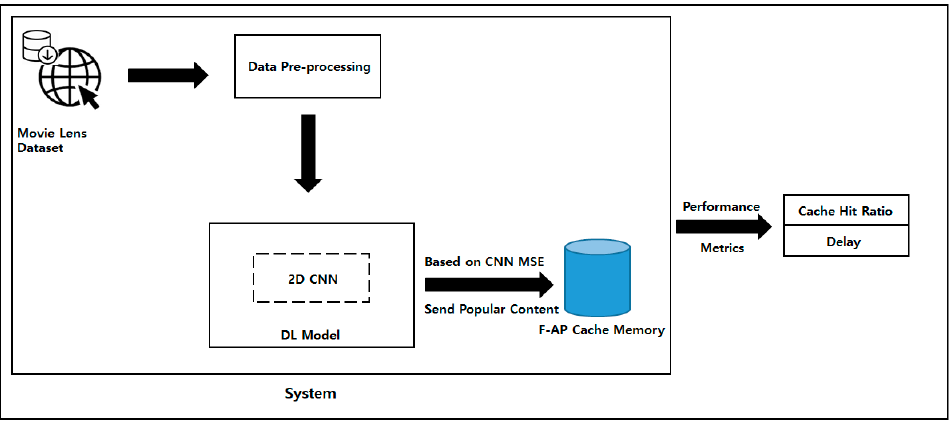
Figure 1. Methodology for deep learning-based content caching (DLCC).